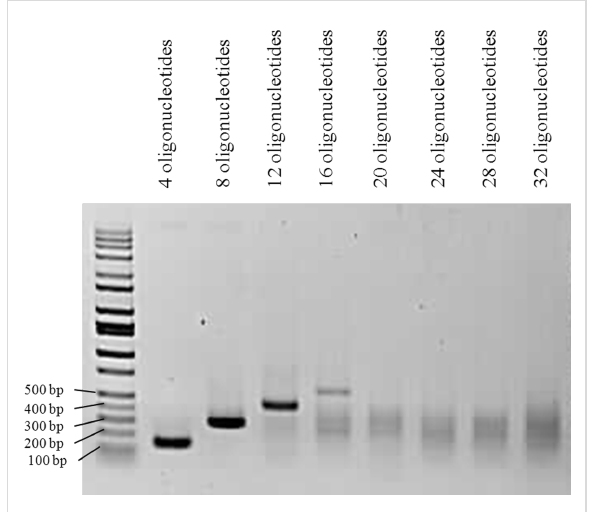
Figure 8: Fragments built only from standard nucleotides, without AEGIS, and designed by OligArch [21] to support the 32B assembly (Supporting Information File 1, Figure S2) resulted in successful self- assembly of up to 16 pieces, in decreasing amounts as the constructs became longer, where the 16-fragment assembly was recovered by PCR. However, under these conditions PCR failed to recover longer assemblies built from 20, 24, 28, or 32 fragments. This represents an experience common when attempting autonomous assembly of DNA single strands. Shown is a 1% agarose gel resolving those products, with ladder at